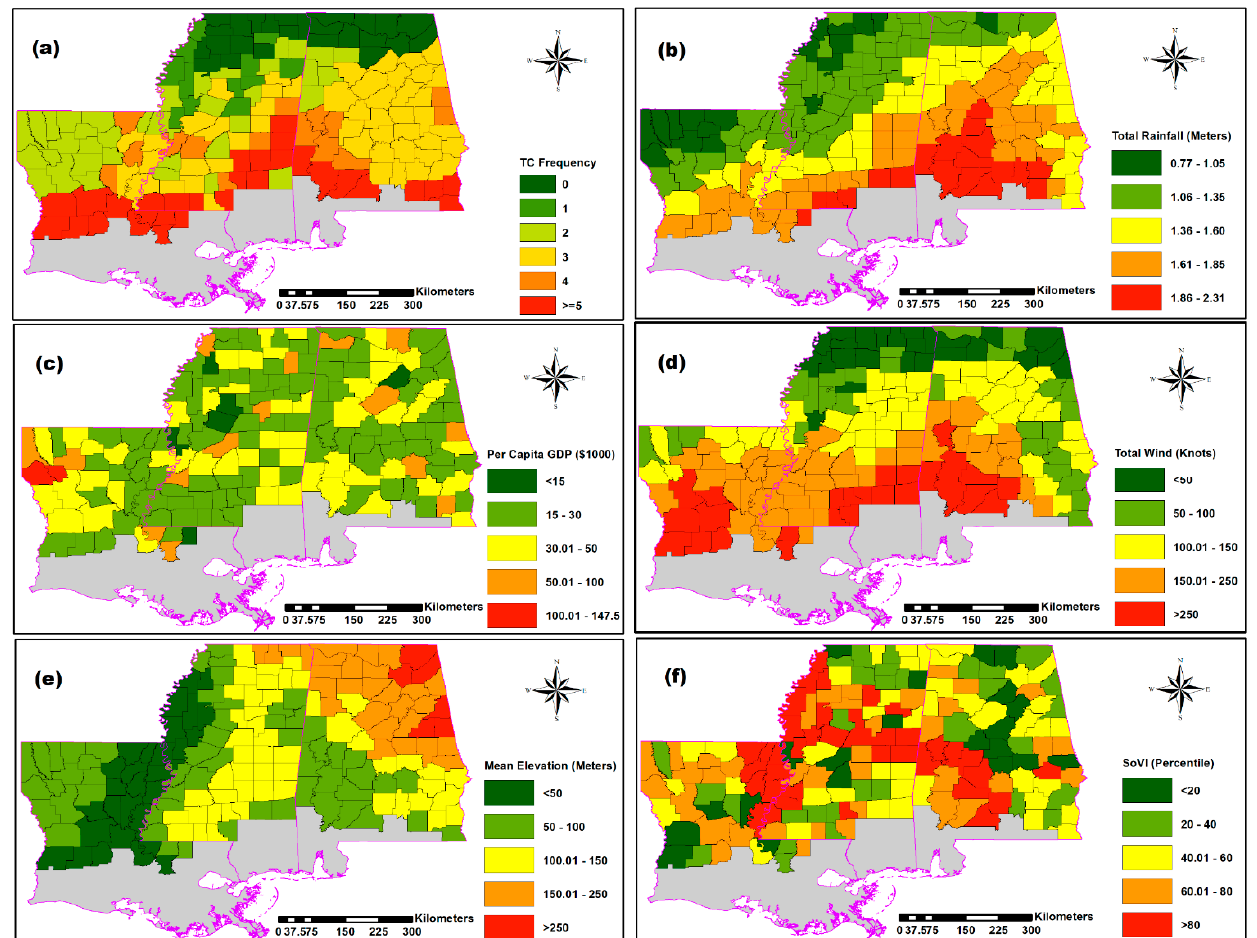
Figure 3. Spatial patterns and distributions of six factors: ( a ) TC frequency; ( b ) total TC rainfall (m); ( c ) county per capita GDP; ( d ) total TC wind (knots); ( e ) county mean elevation (m); and ( f ) county SoVI percentile.